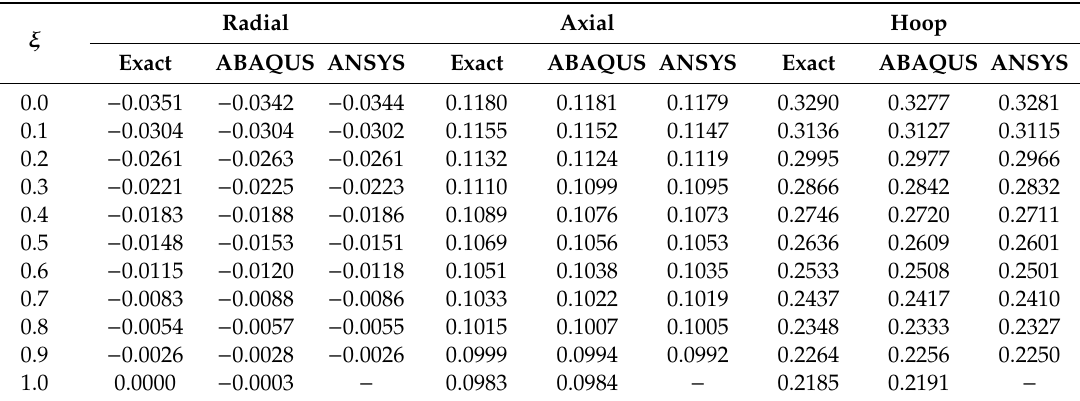
Table 3. Stress comparison of the cylinder (MPa).